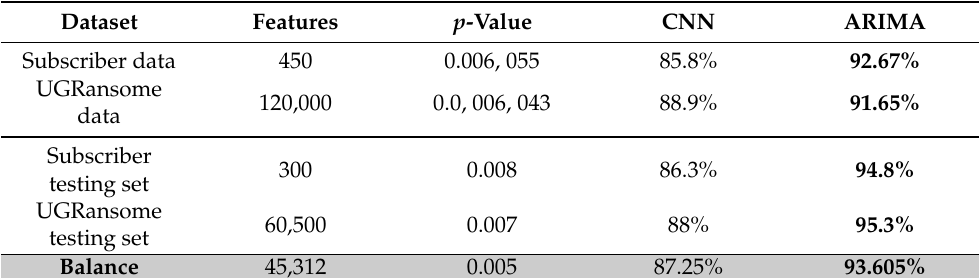
Table 7. The CNN and ARIMA